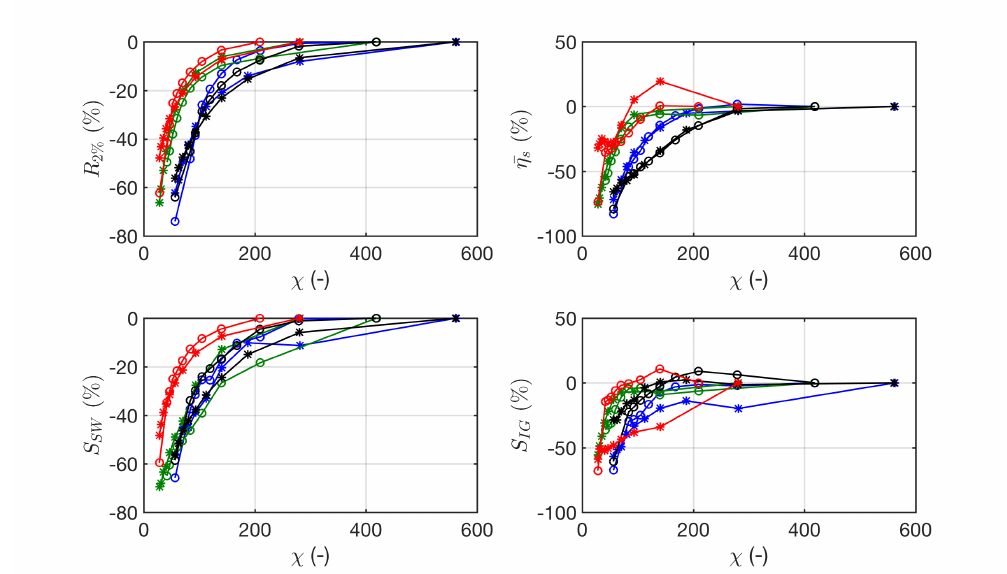
Figure 10. Self-contained deviation of the runup components from the results obtained with the smallest grid size as a function of χ . For markers and curves colors, refer to Table 6.